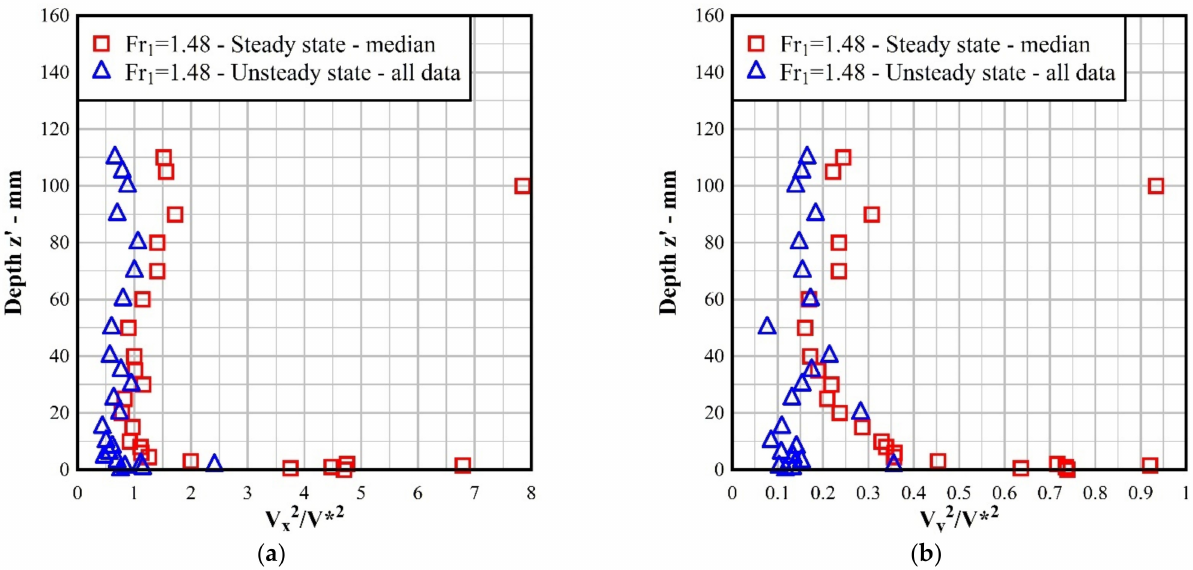
Figure 7. Breaking surge, Run 60-6. Dimensionless normal Reynolds stresses ( a ) V x 2 / V * 2 ; ( b ) V y 2 / V * 2